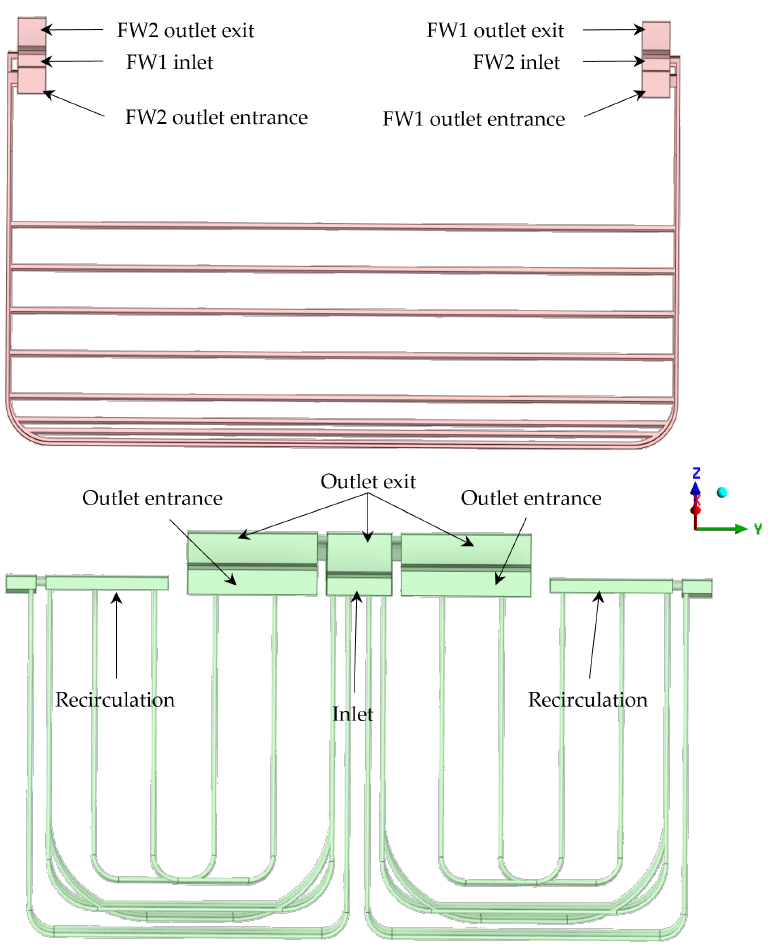
Figure 6. Water manifolds boundary sections: SB ( top ) and BZ ( bottom ) cooling